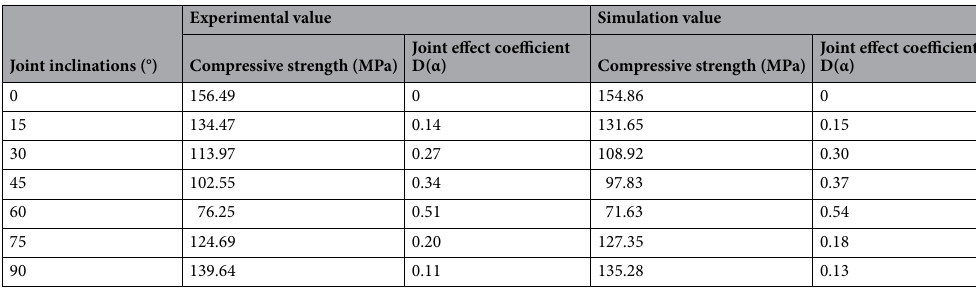
Figure 23 is a schematic diagram of progressive fracture process obtained by simulating uniaxial compression failure of Phyllite under different joint inclinations. It can be seen from the figure that the failure mode of phyl- lite is greatly affected by the joint direction, and can be divided into three types according to the failure mode. (A) Shear failure, when the 0° ≤ α ≤ 15°. Under the action of the load, the phyllite first appeared small cracks in the lower strength position, and then the cracks continued to extend and expand under the action of external force, Its extension direction is not along the direction of the Joint direction, but forms a certain angle with the Joint direction, and finally a slanted crack is formed and the rock is destroyed. (B) Tensile and shear damage (30° ≤ α ≤ 75°). The initial cracks began to appear in the local area of phyllite, and the cracks showed a tendency to expand along the joint direction under load. In addition, there is a strong cementation between the stratified phyllite matrix and the joint surface, so the surrounding minerals are affected by a tensile force during the crack extension stage, and finally show tensile and shear failure. (C) The dissociation tension failure (90°), when = 90°,